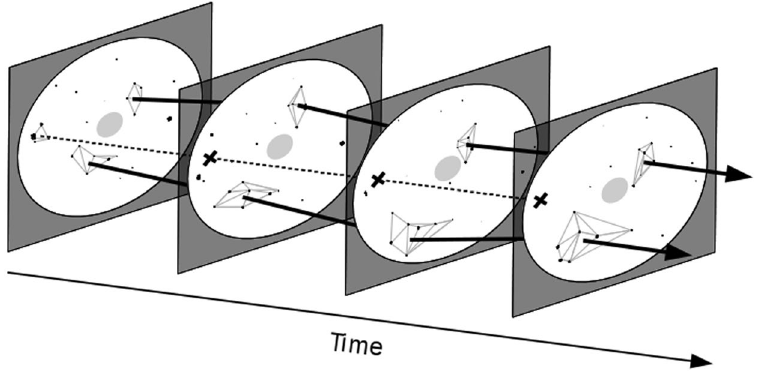
Figure 2. This illustration depicts the tracking procedure of clusters’ centroids. The four panels correspond to four successive schematised radar images. In each image, white circle represents the scanned radar disk, black dots are seabird-echoes, and the central light grey circle symbolises the central saturated zone where no information is available. Black arrows crossing radar disks link clusters of echoes showing spatial and temporal consistency. Dotted line and black crosses stand for missing linkages of a cluster’s centroid in three successive images, thus closing the tracking procedure for this cluster. The latter is invalidate by the tracking procedure and considered as a non-consistent structure in seabirds distribution.